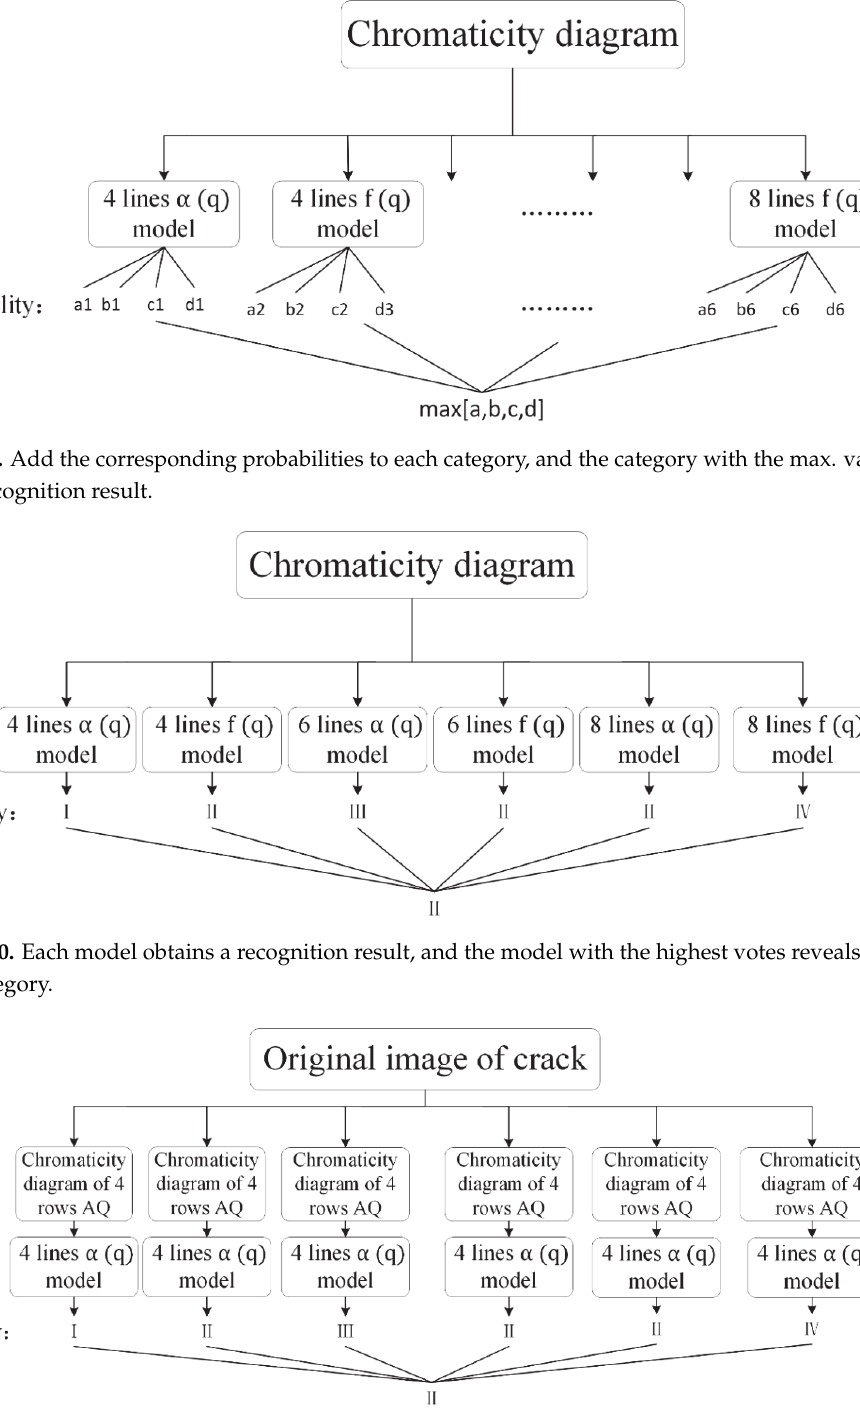
Figure 11. Improved fusion method.